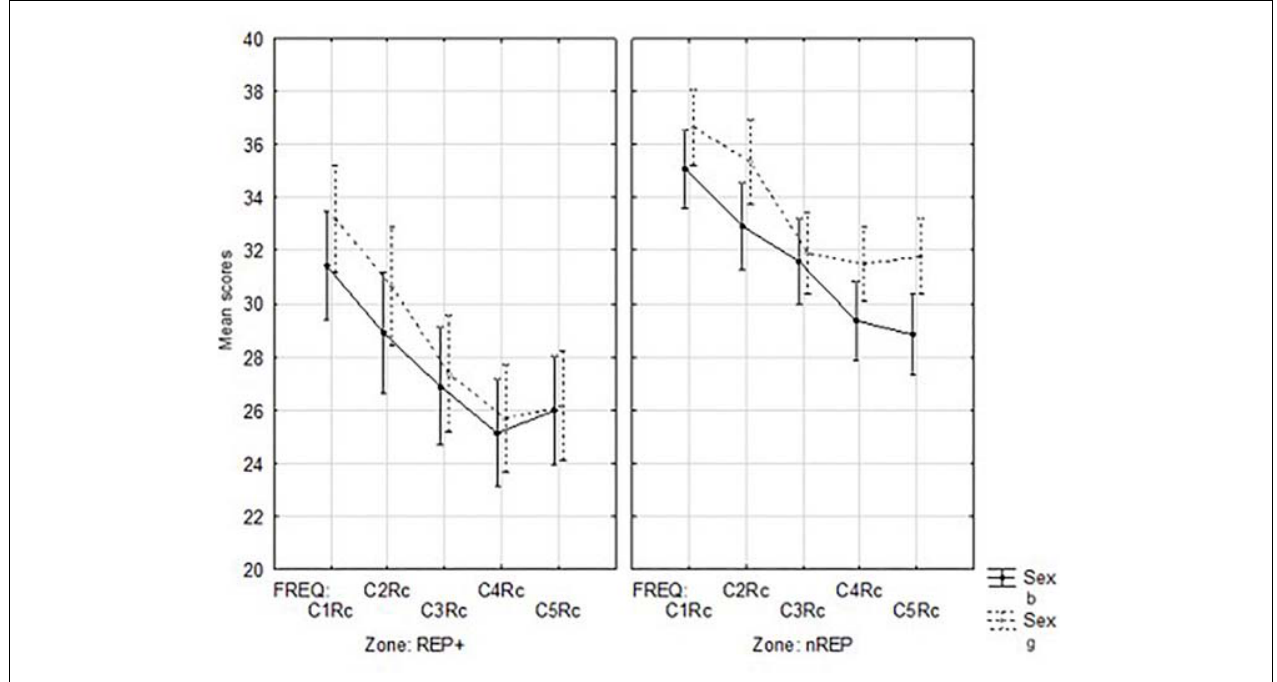
FIGURE 2 | Mean correct response scores as a function of sociodemographic Zone, Gender, and Word Frequency. Notes : g, girls; b, boys; nREP, outside of REP; FREQ, word frequency; RcTot, Total Correct Responses; Vertical bars denote confidence